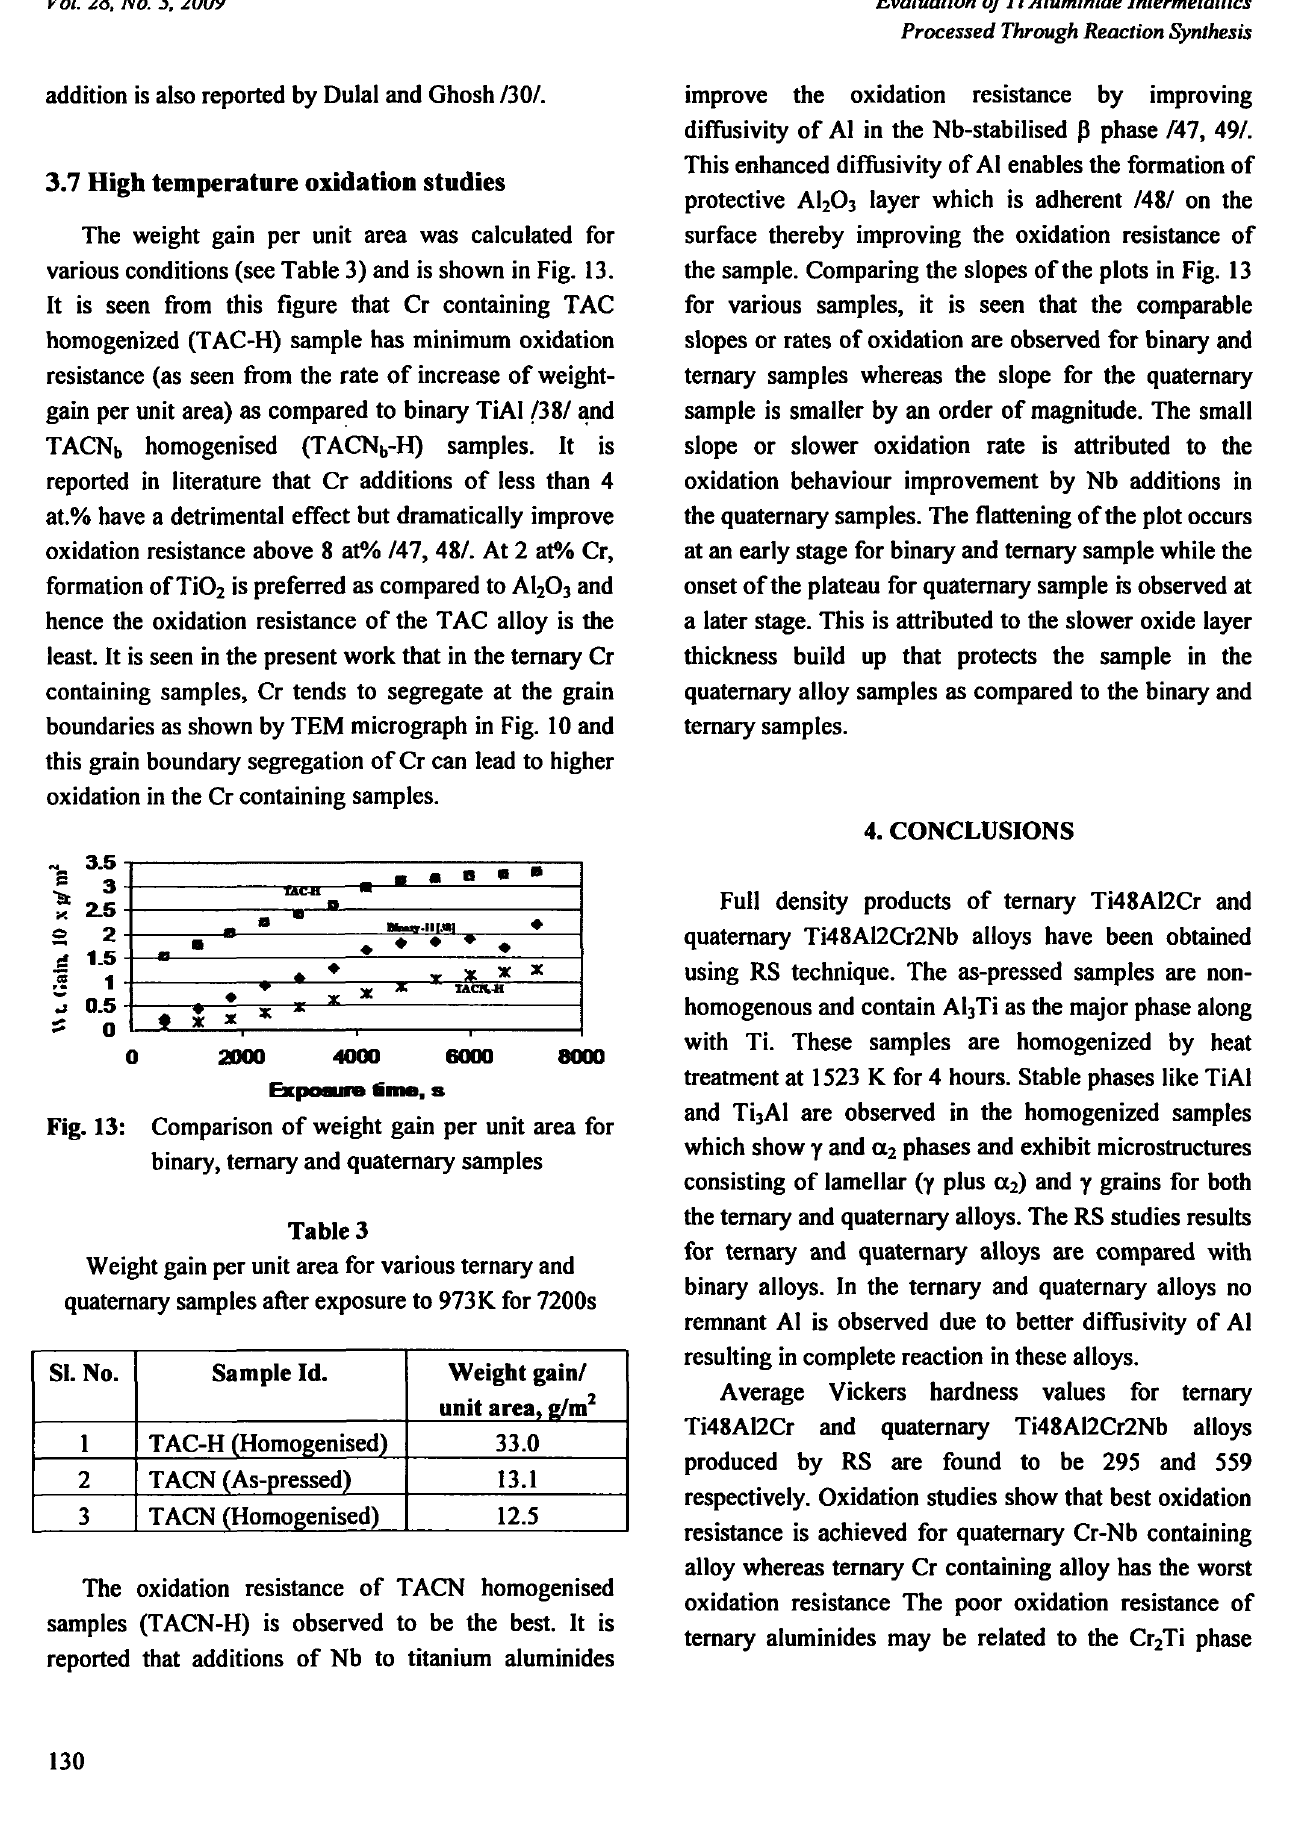
Weight gain per unit area for various ternary and quaternary samples after exposure to 973K for 7200s SI.